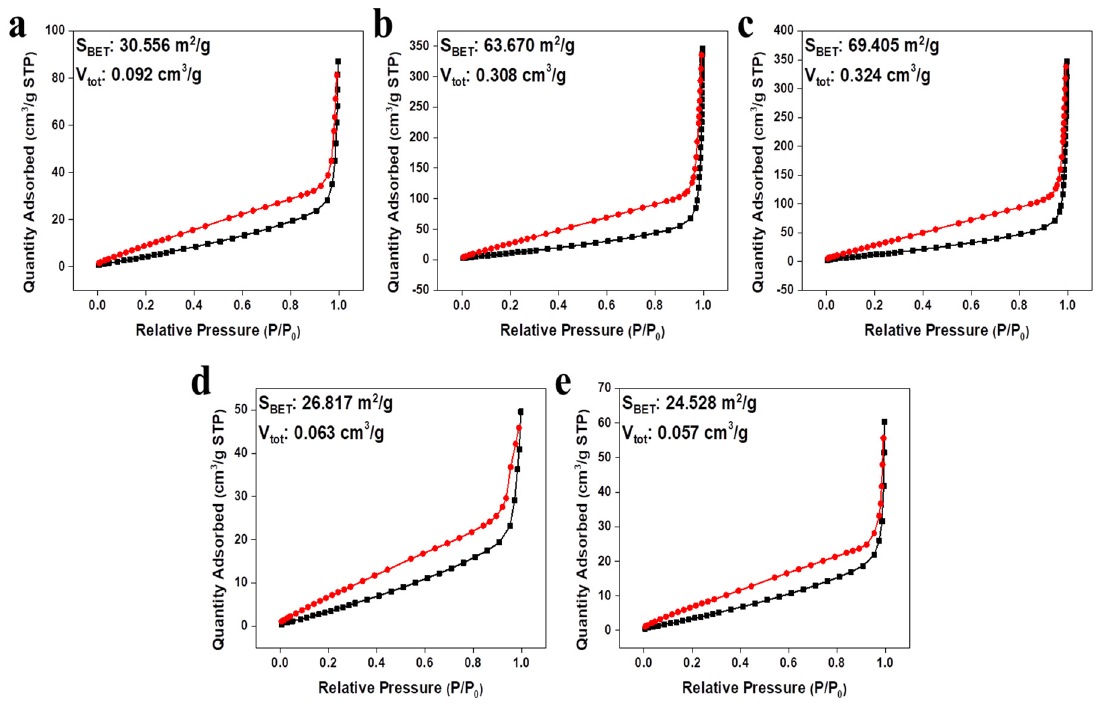
Figure 3. BET graphs of ( a ) Zn@TiA, ( b ) Zn@Ti-B, ( c ) Zn@Ti-C,( d ) Zn@Ti-D, and ( e ) Zn@Ti-E.